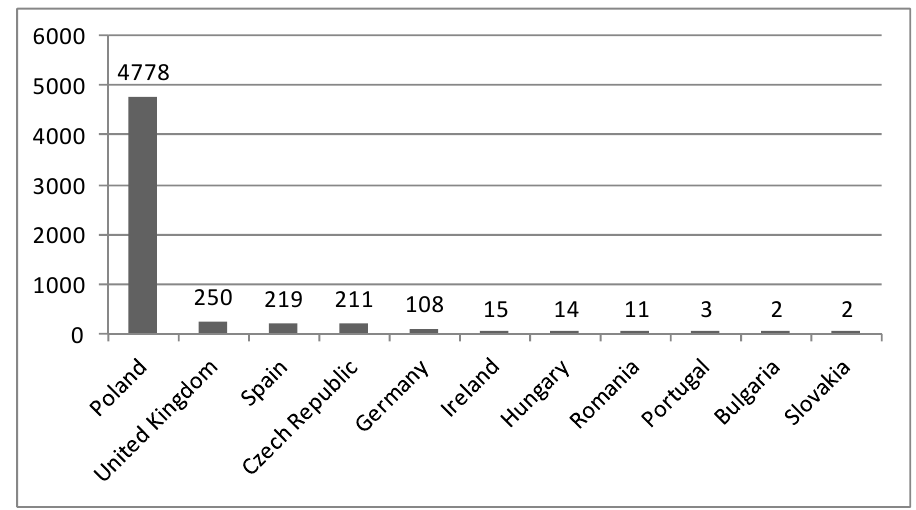
Figure 3. Hard coal resources in EU countries in 2018 (million tonnes) [45].